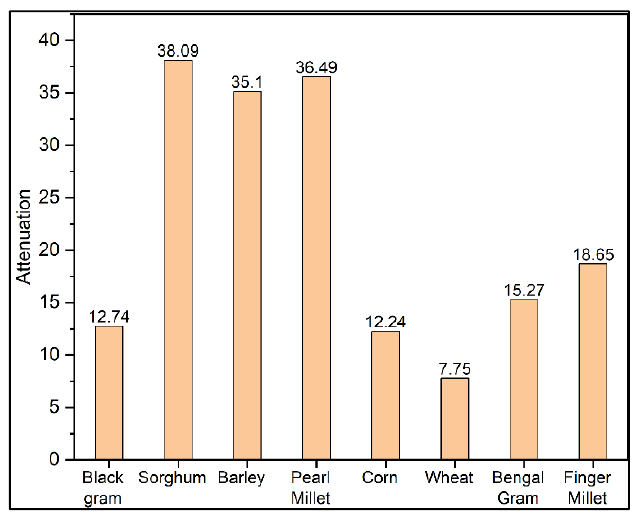
Figure 4. Comparison of input voltage, output voltage and attenuation for rice flour, wheat flour, nut flour and their mixtures.